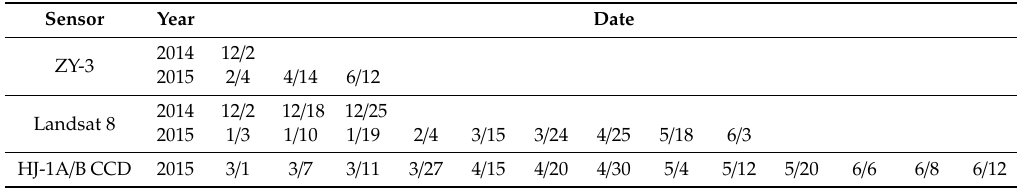
Table 1. List of the data used in this study.